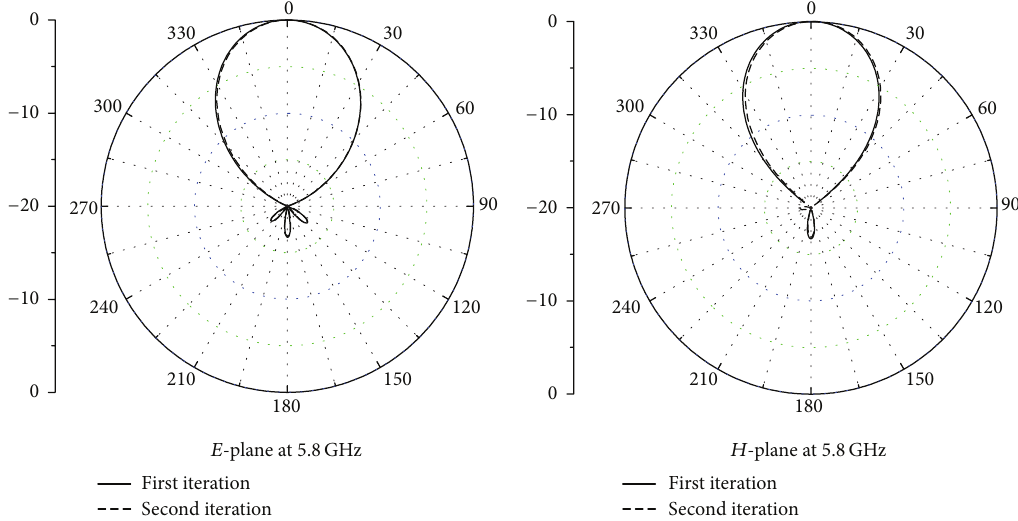
Figure 11: Comparison of the radiation patterns of the fractal iterations, 1st and 2nd.